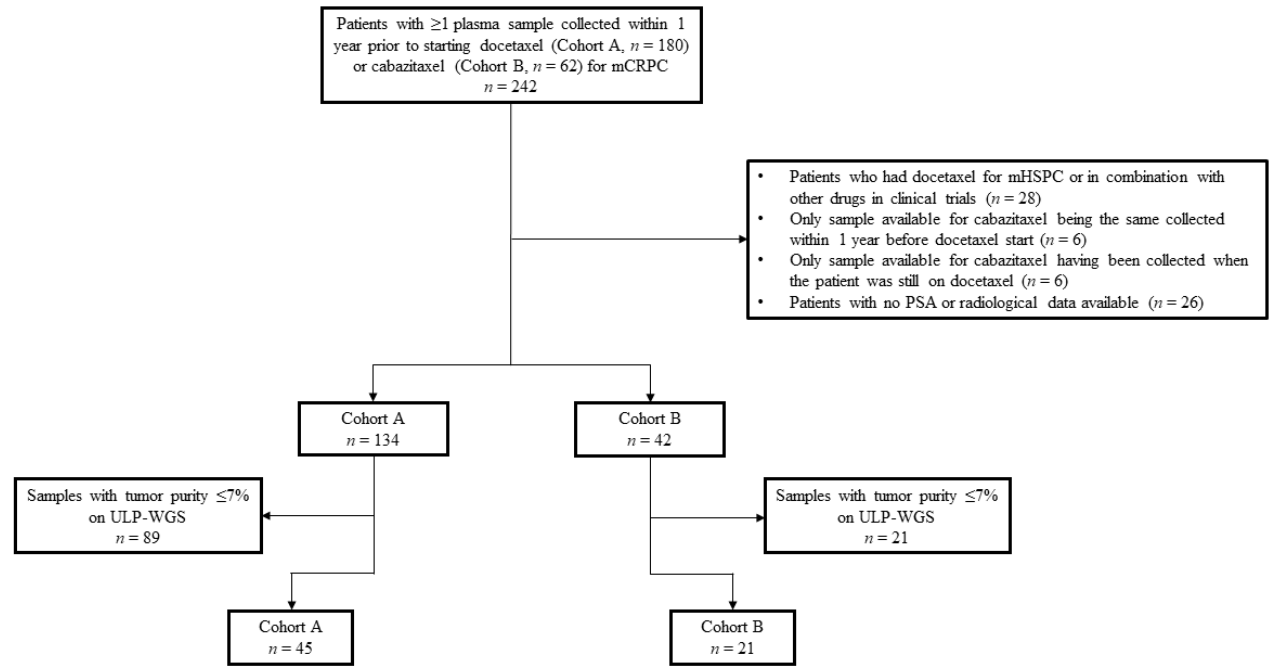
Figure 1. Schema of the clinical cohorts. Diagram describing reasons for excluding patients/samples from the initially 242 patients identified in the CRIS database. Abbreviations: mHSPC, metastatic hormone-sensitive prostate cancer; mCRPC, metastatic castration-resistant prostate cancer; PSA, prostate-specific antigen; ULP-WGS, ultra-low pass whole genome sequencing.